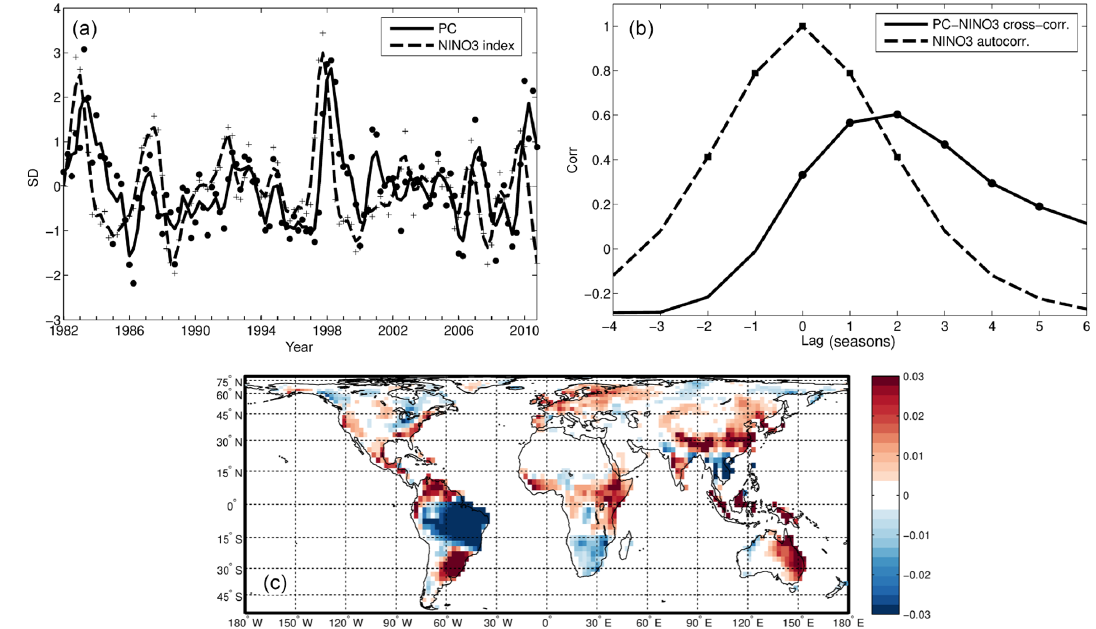
Figure 4. (a) Second normalized PC of the PRE anomalies forced by the SM (full line and filled circles). Dashed line (and cross marks) stands for the normalized NINO3 index. Lines stand for three-season running means, while marks represent each single season. (b) Lagged correlations between NINO3 index and PC1 of forced PRE. The dashed curve is the autocorrelation function of the NINO3 index. Marks indicate significance at the 5% level. (c) Second EOF of the forced PRE. Arbitrary